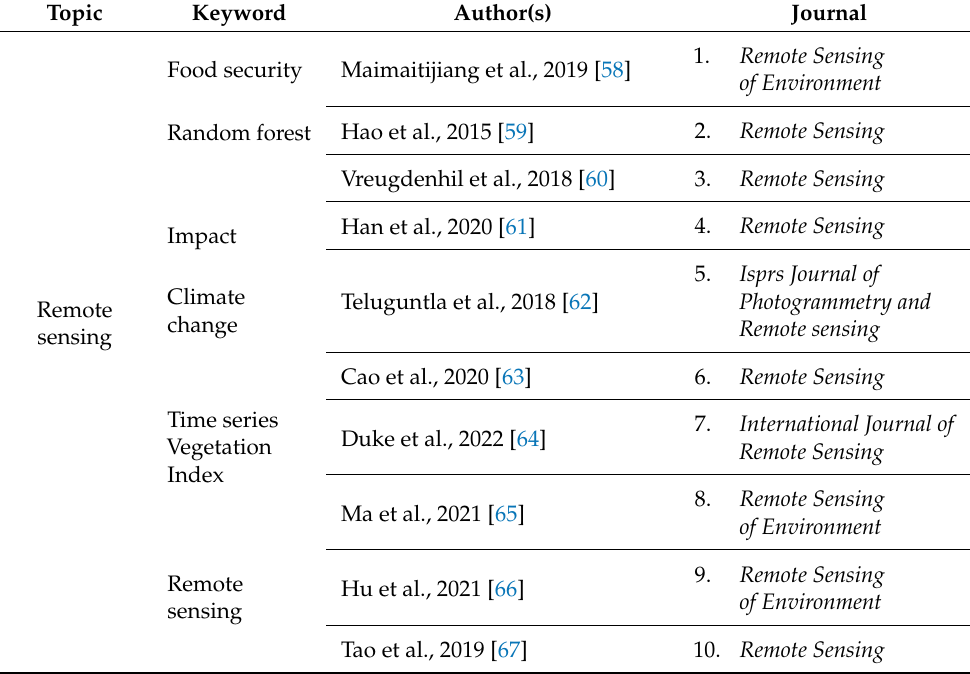
Figure 13. Keyword cluster analysis. Table 1. Topics, keywords, authors, and journals.